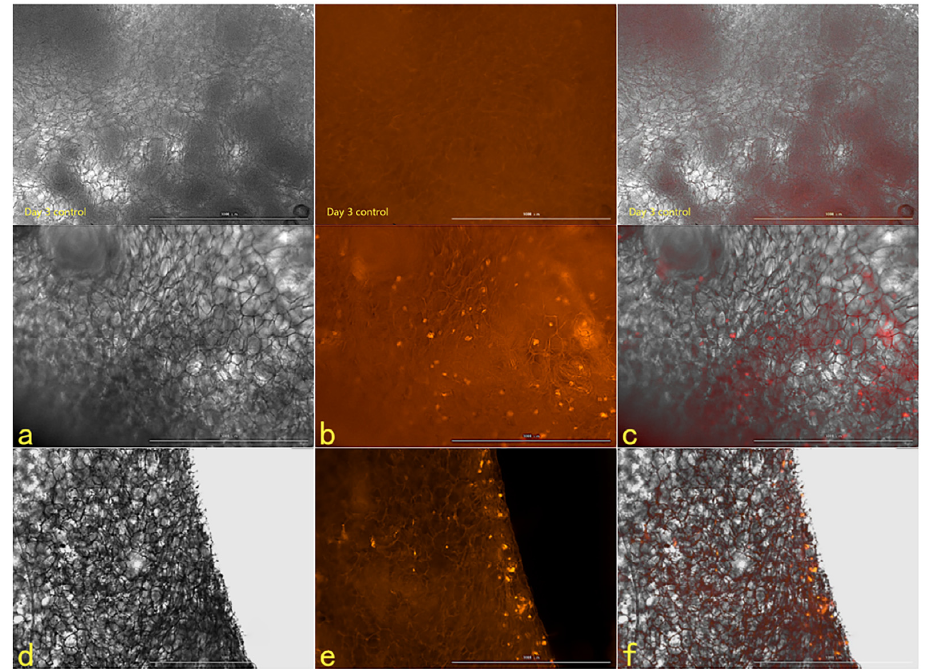
Figure 16. The HSFs detected on a three-dimensional scaffold, day 3. In the picture, ( a – c ) are the front of the stent, and ( d – f ) are the cross sections of the stent. ( a , d ) are bright fields, ( b , e ) are fluorescent fields, and ( c , f ) are composite pictures of bright fields and fluorescent fields. Control: only cell scaffolds and a culture medium containing AGQDs, no HSFs. Scale bars: 1000 μ m.